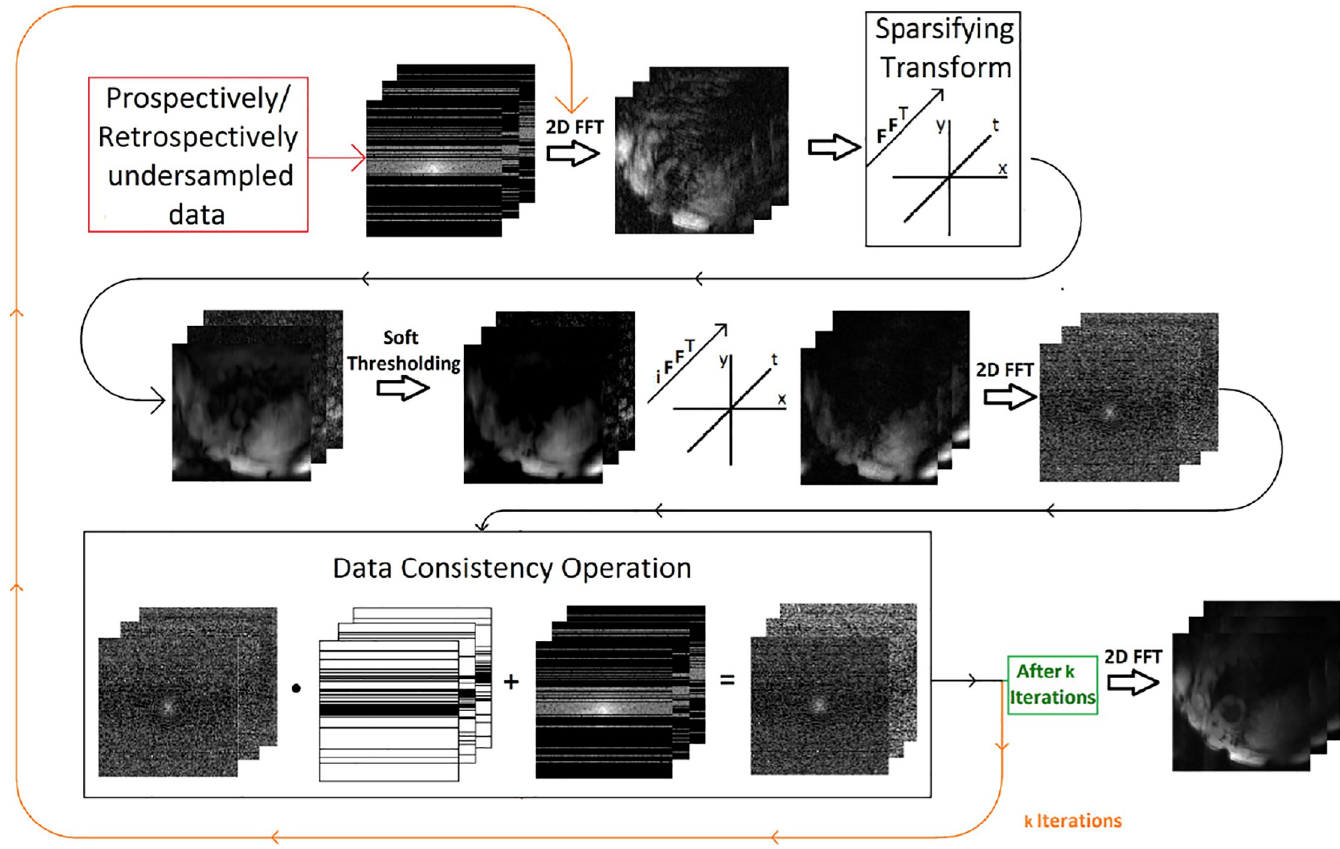
Fig 2. The reconstruction algorithm. An overview of the TPM CS reconstruction